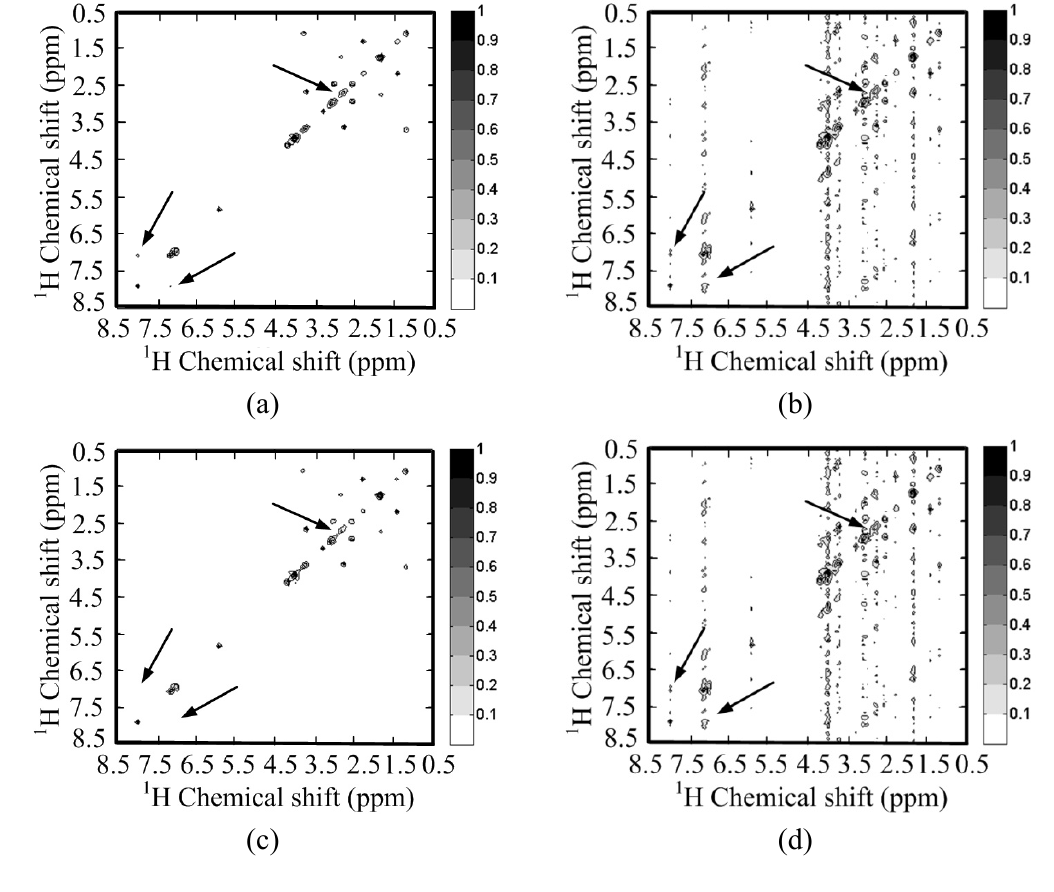
Figure 9. CS reconstruction of a 2D 1 H- 1 H COSY spectrum using wavelet and identity matrix. ( a , b ) reconstructed spectra using fully sampled FID and undersampled FID with zero filling, respectively; ( c , d ) reconstructed spectra using wavelets and identity matrix norm, respectively; ( e , f ) reconstructed spectra using wavelets and with IST-based ℓ 1 norm, respectively; ( g , h ) reconstructed spectra using identity matrix with PSOCA-based ℓ 1 norm, wavelets and identity matrix with PSOCA-based ℓ p